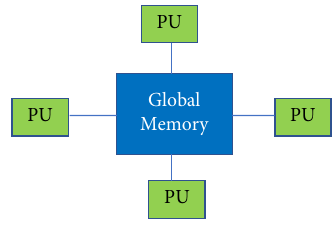
Fig. 3 Shared memory architecture.